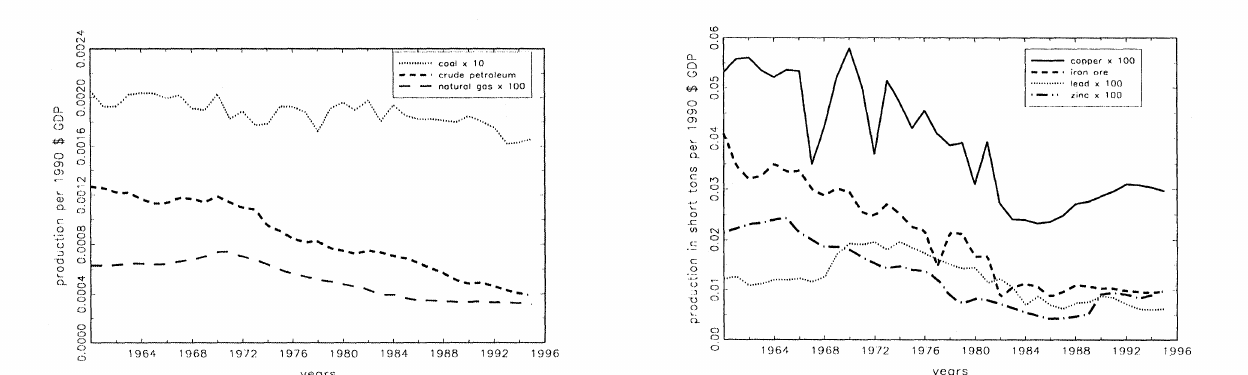
FIGURE 3 Metal: production per GDP (metal production in short tons).